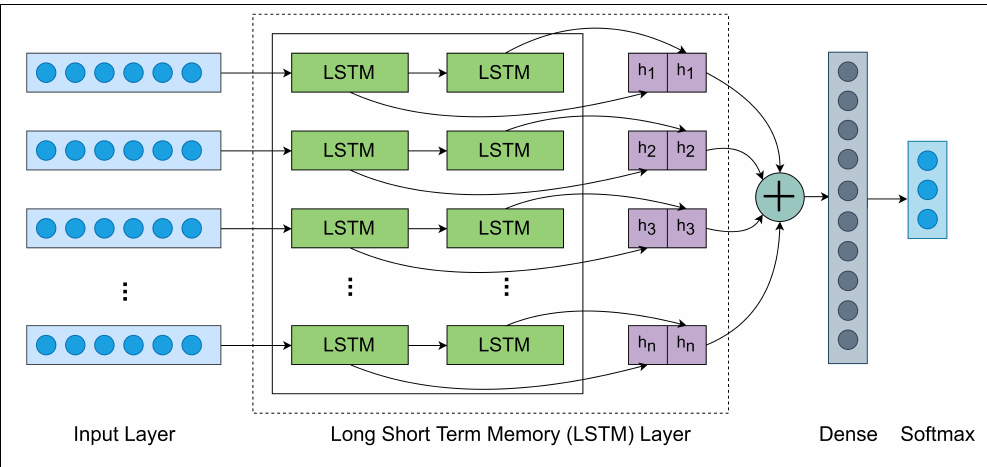
Figure 7. Overall Architecture of Recurrent Neural Network